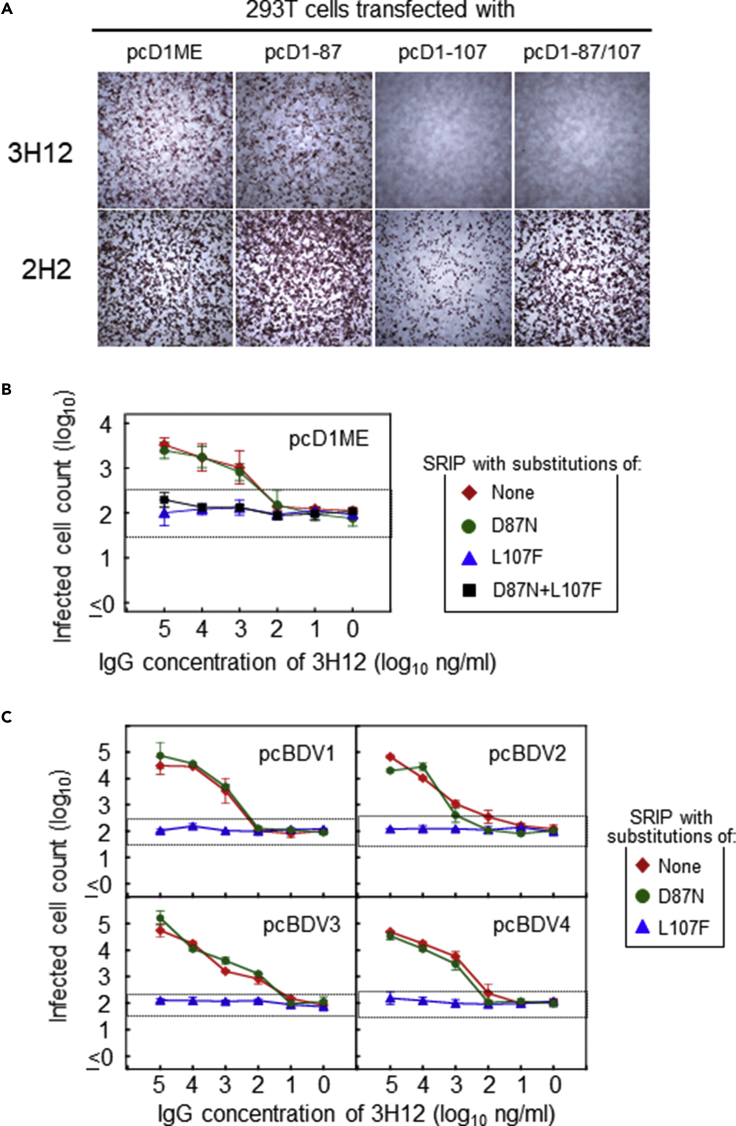
Determination of 3H12-Binding Site(A) Micrographs of 293T cells transfected with pcD1ME or its variants. At 24 h after transfection, the cells were fixed and immunostained with 3H12 or 2H2.(B and C) Enhancing activities of 3H12 against SRIPs generated using pcD1ME variants (B) or pcBDV1–4 variants (C) designed to contain amino acid substitutions of D87N and/or L107F. The x axis shows the 3H12 IgG concentration, and the y axis displays the infected cell counts (in log10). For dotted lines, see the legend of Figure 2. Data represent averages of two independent assays ± SD.